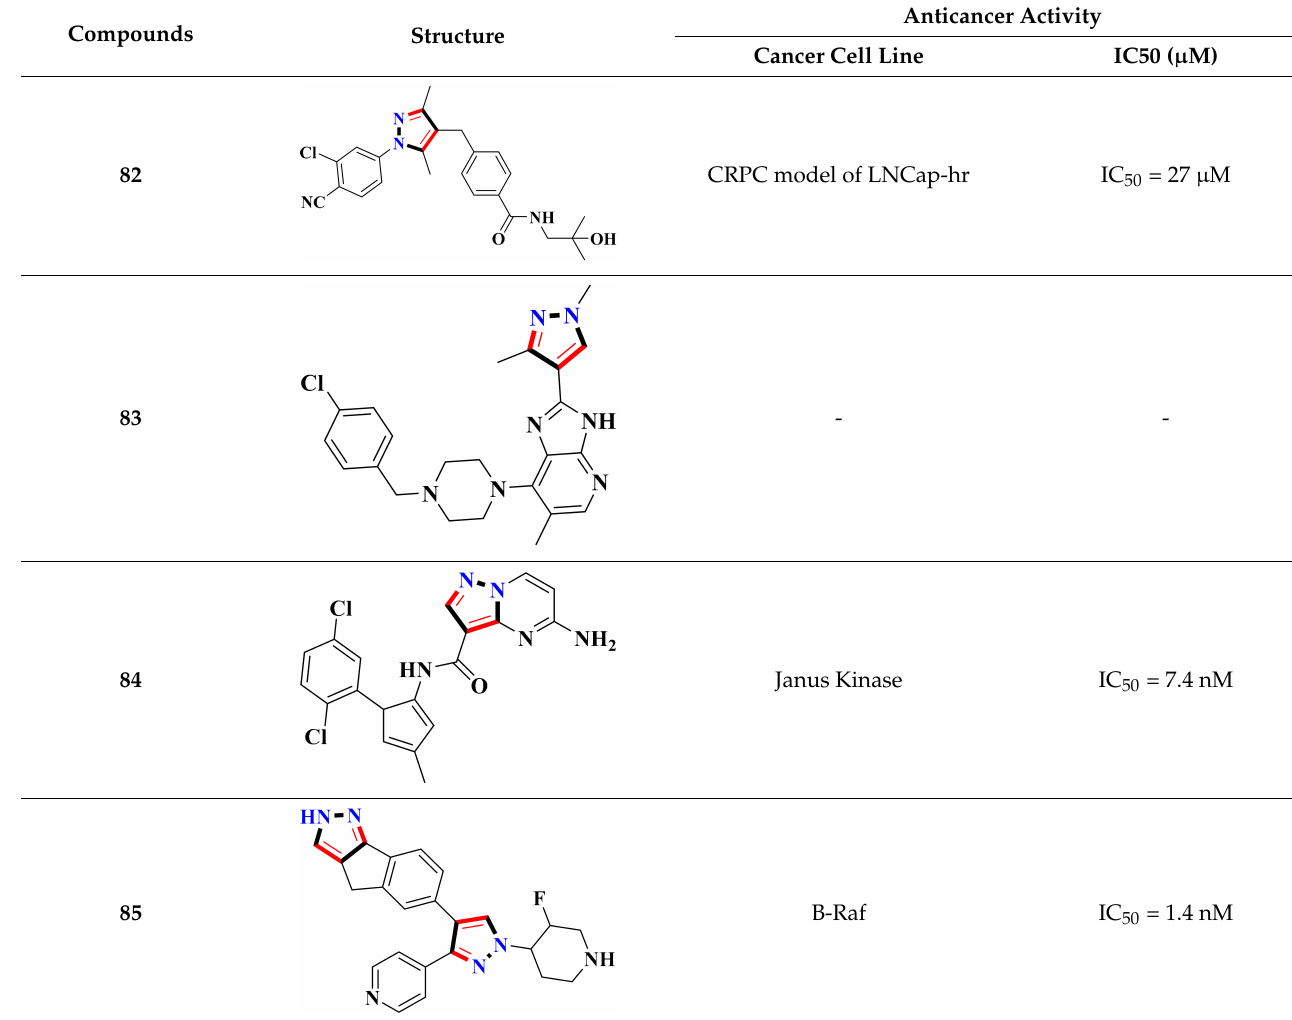
Table 7. Representative compound structures 82 to 99 and their anticancer